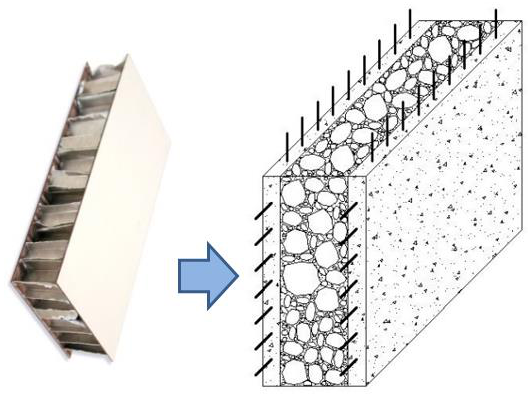
Figure 4. Statics of the resisting mechanism: from a sandwich panel to an FRM-reinforced wall.